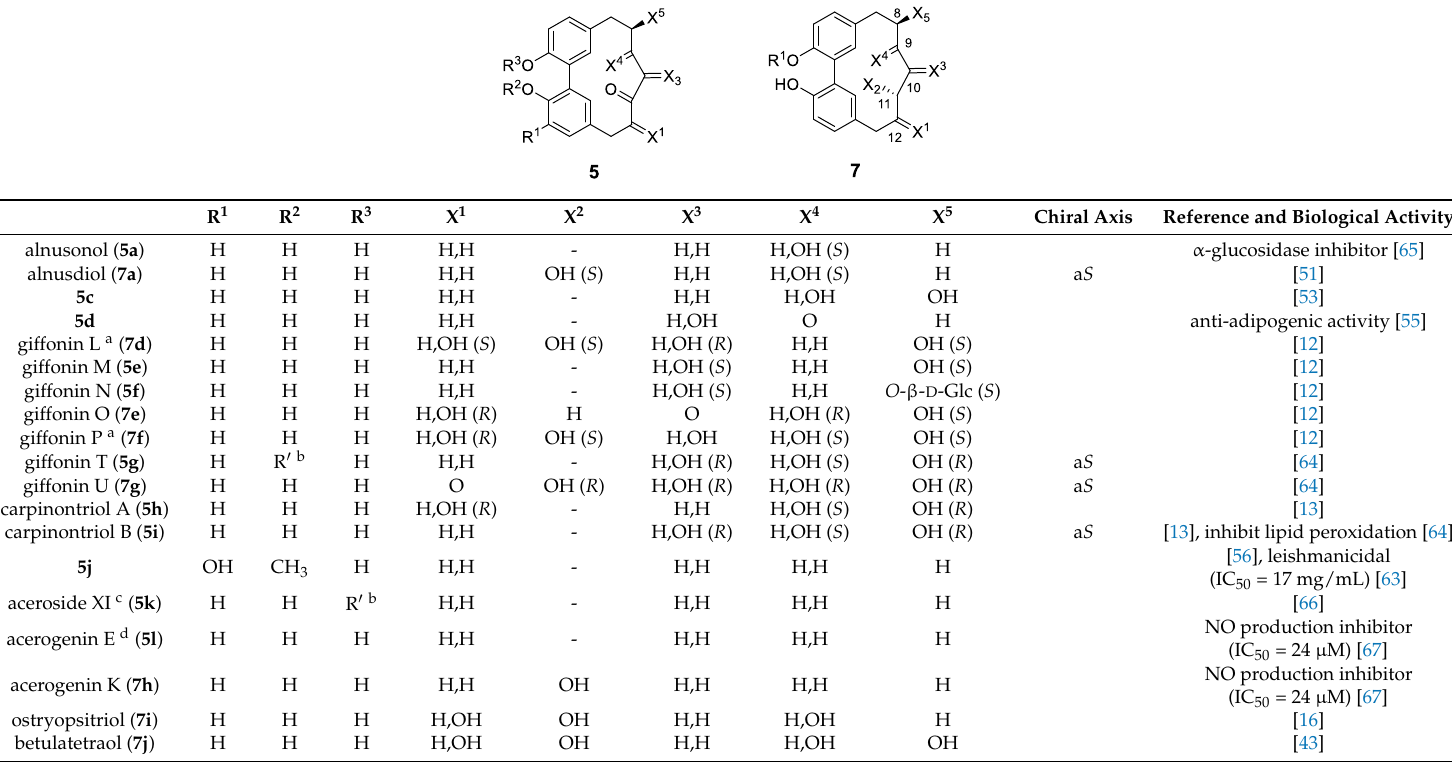
Table 2. Derivatives of alnusonol ( 5a ) and alnusdiol ( 7a ), and their stereochemistry.